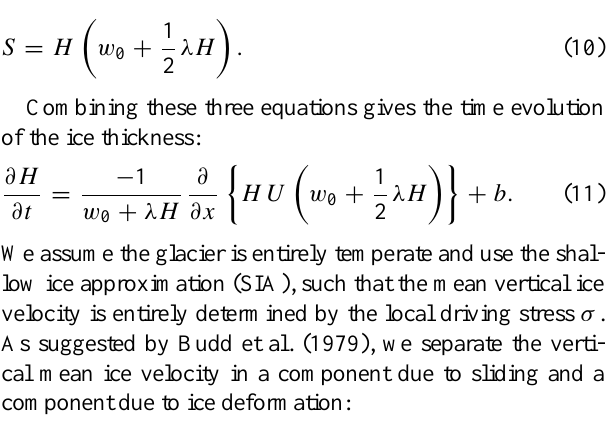
Fig. 5. Mass balance profile b ref (z) calculated from 1980–2009 average forcing. NB: the profile is given for the entire model do- main; the terminus is at 1450m in 2009 (glacier length=5550m); the modelled steady-state terminus is at 1200m altitude (glacier